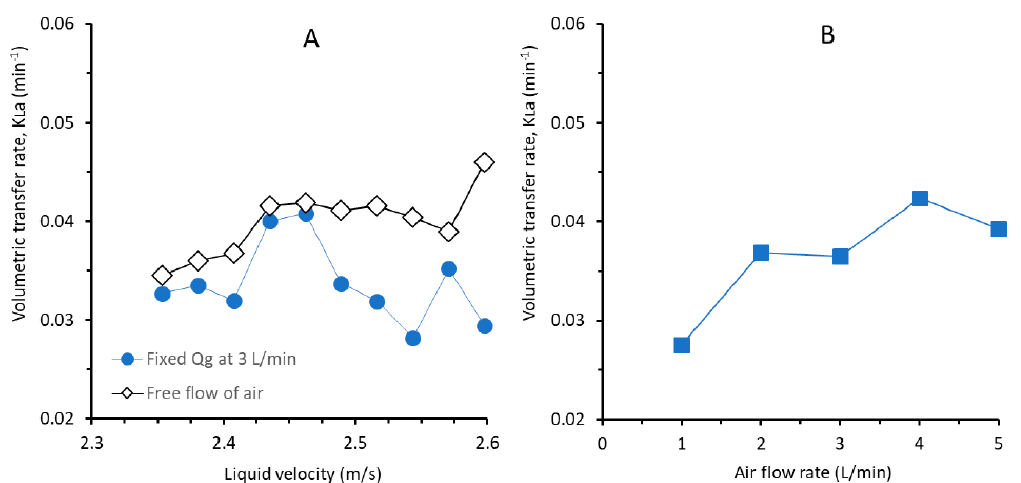
Figure 9. E ff ect of liquid velocity at fixed air velocity of 3 L / min and under free flowing of air ( A ) Figure 9. Effect of liquid velocity at fixed air velocity of 3 L/min and under free flowing of air ( A ) and and the e ff ect of air velocity at a constant liquid velocity of 2.46 m / s ( B ) on the volumetric mass the effect of air velocity at a constant liquid velocity of 2.46 m/s ( B ) on the volumetric mass transfer transfer coe ffi coefficient.